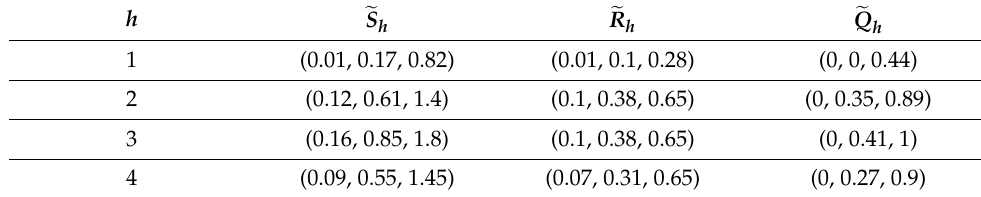
Table 7. The (cid:101) S h , (cid:101) R h and (cid:101) Q h of each leisure agricultural